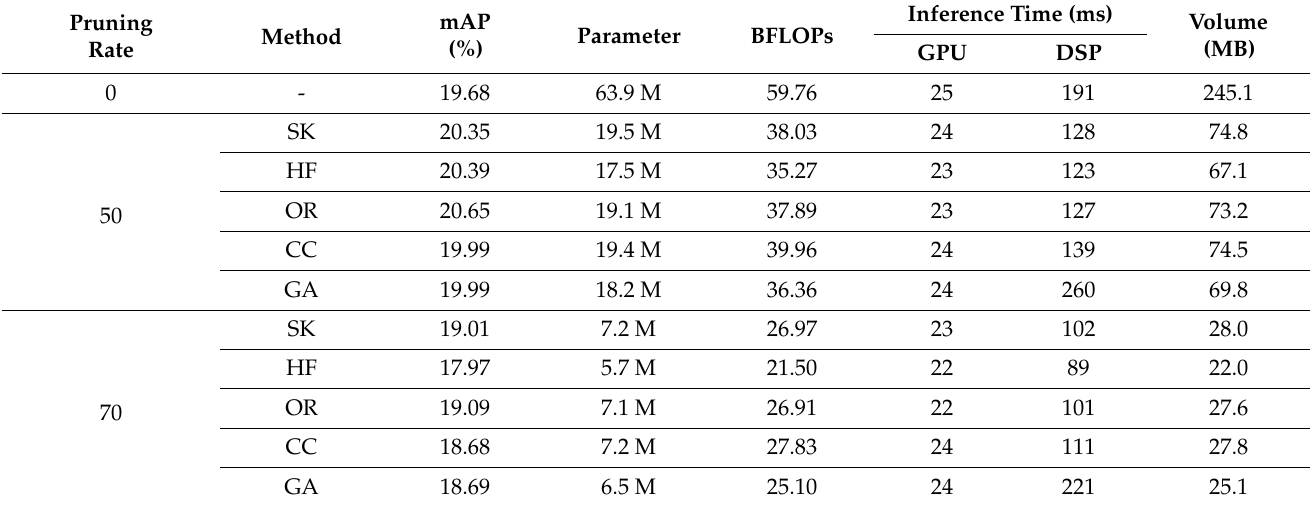
Table 5. Comparison pruning results in VisDrone-DET2019.